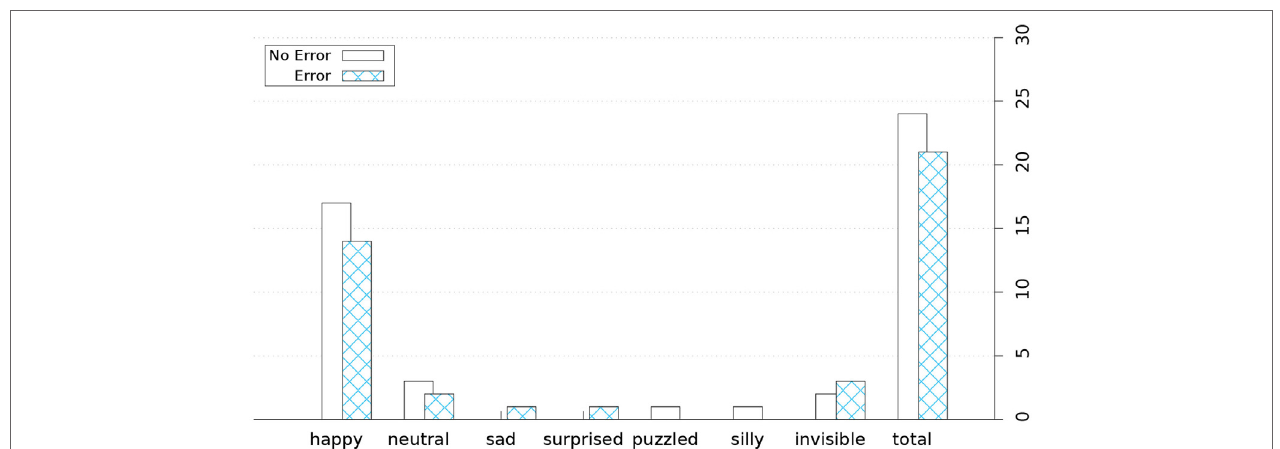
FigUre 6 | emotions the participants expressed during the legO session .